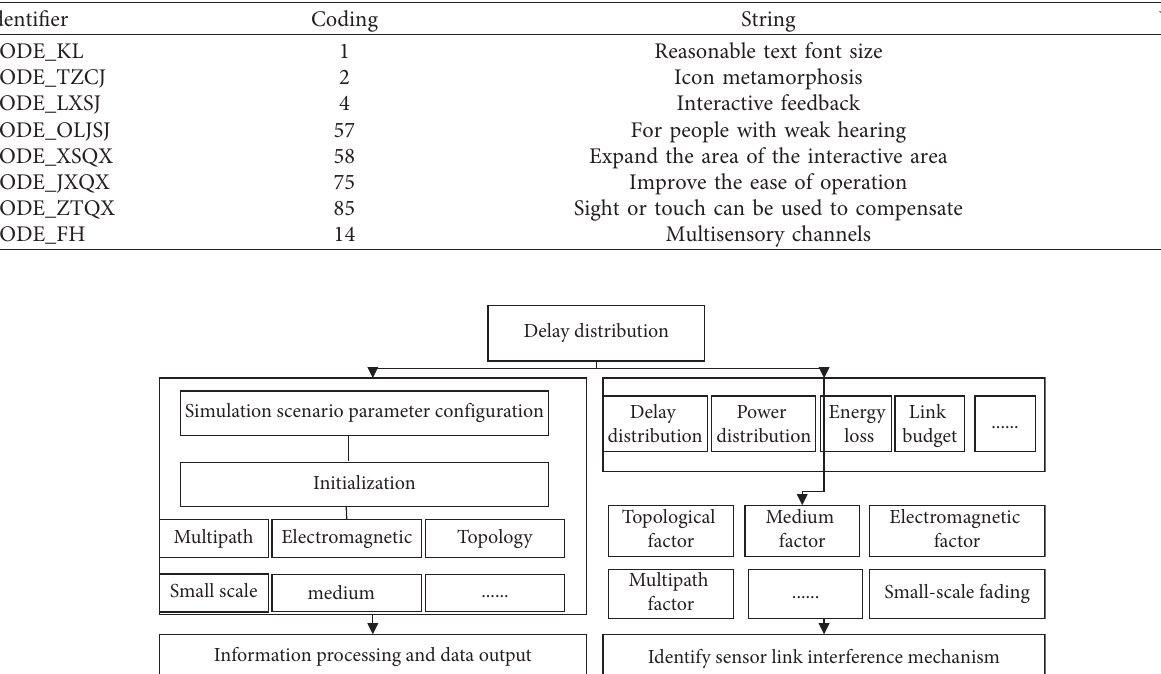
Table 1: Speech recognition commands.